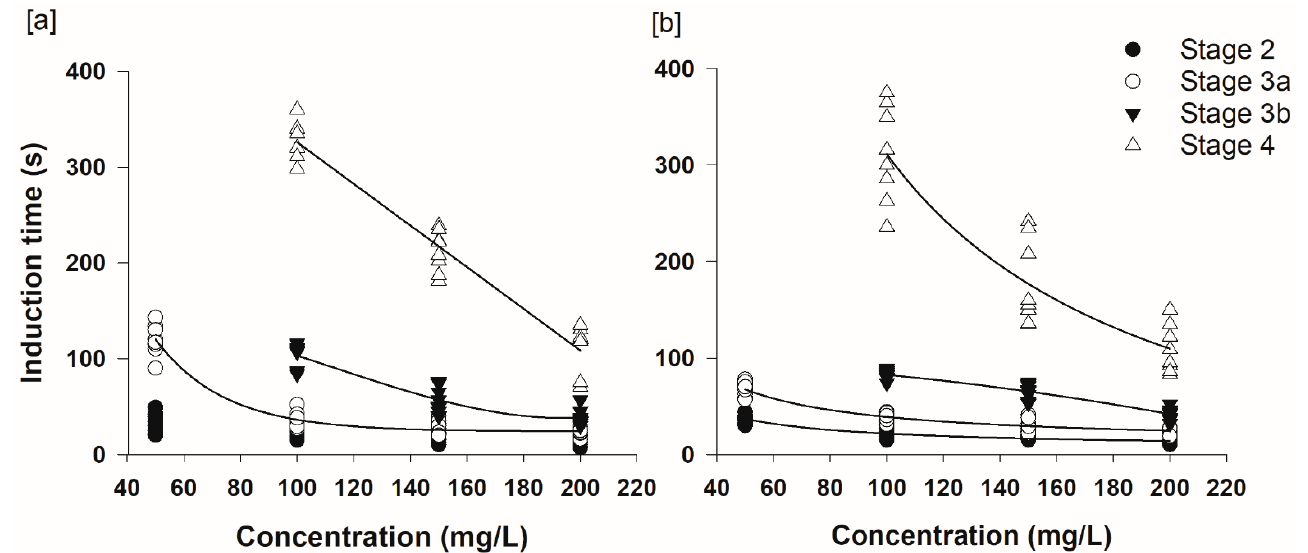
Figure 3. Relationships of concentration x anesthesia induction time in silver catfish ( Rhamdia quelen